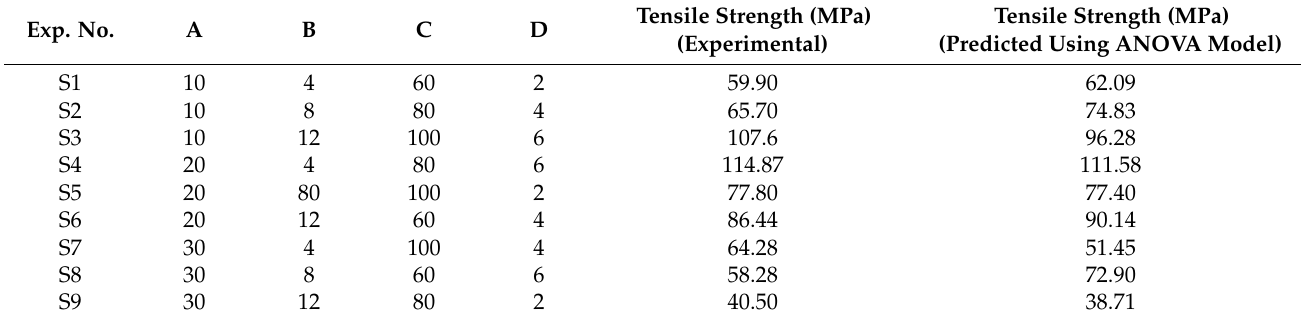
Table 12. Composite manufacturing parameters with formulation [135].